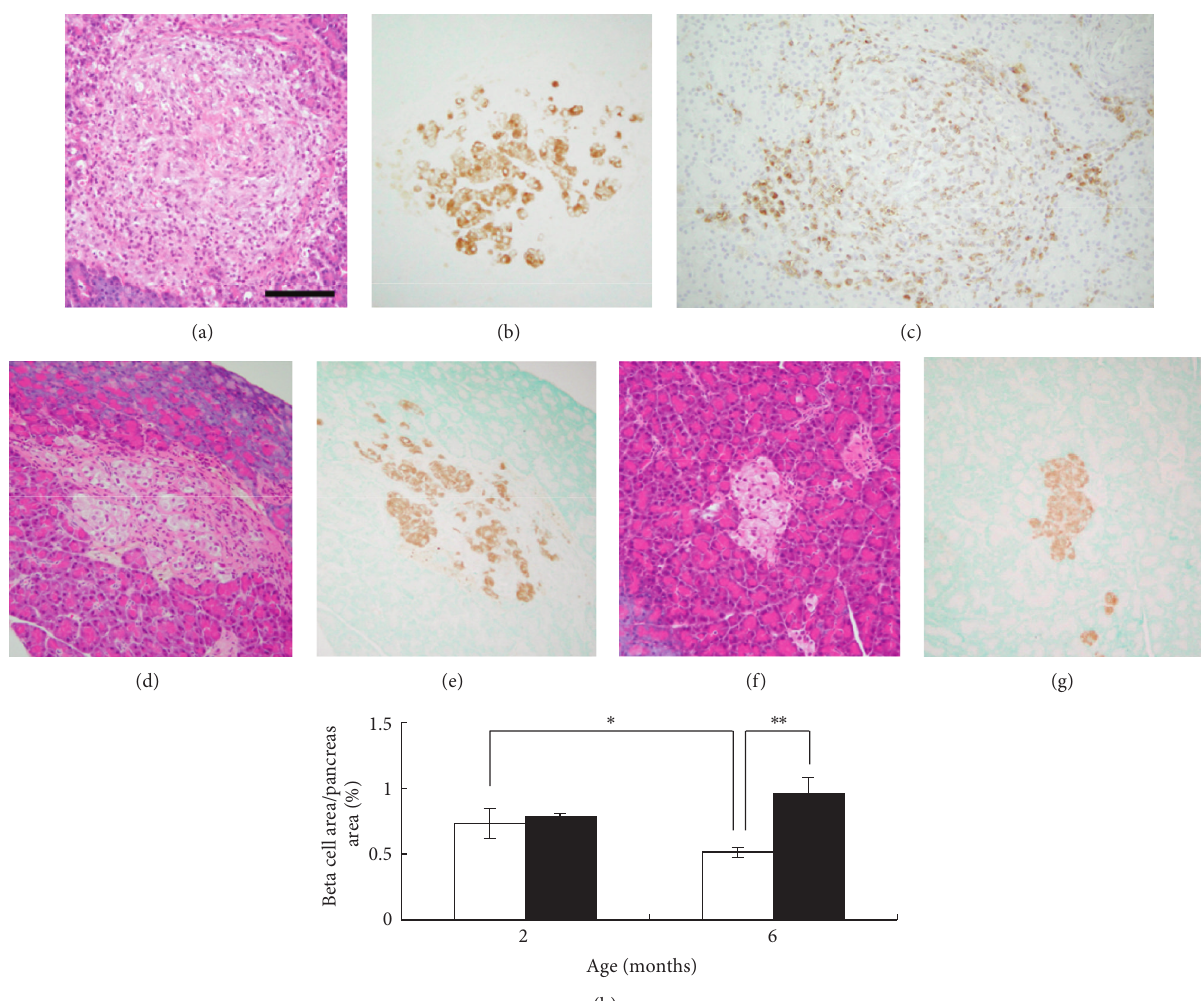
Figure 4: Histopathological appearance of pancreatic islets of male LEA rats. At 2 months of age, H&E staining (a), staining with anti-insulin antibody (b), and staining with anti-ED1 antibody (c). At 12 months of age, H&E staining (d and f) and staining with anti-insulin antibody (e and g). Sections (b), (e), and (g) correspond to sections of (a), (b), and (f). Scale bar = 100 𝜇 m. (h) Changes in the proportions of 𝛽 -cells in the pancreas with age. The areas of the 𝛽 -cells and pancreas were calculated by computer-aided imaging. Open and closed bars indicate male LEA and Wistar rats, respectively, at 2 months and 6 months of age. Each value is expressed as the mean ± SD. ∗ 𝑃 < 0.05 . ∗∗ 𝑃 < 0.01 .